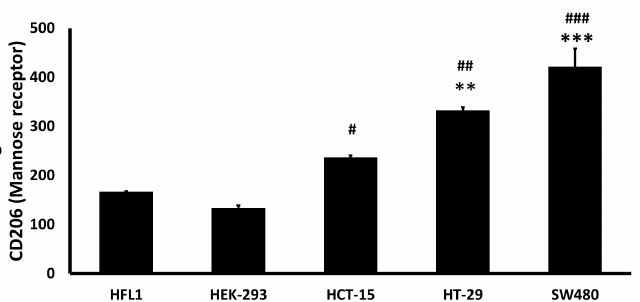
Figure 1. Comparative expression of Mannose receptors between colon cancer and normal epithelial cell lines. Mannose receptor expression on CRC cell lines was higher than the normal epithelial human embryonic kidney cell line (HEK-293) and normal lung fibroblast cell line (HFL1), as detected through flow cytometry. *** p < 0.001; ** p < 0.01 when compared to HFL1; ### p < 0.001; ## p < 0.01; # p < 0.05 when compared to HEK-293. One-way ANOVA followed by Tukey’s test.